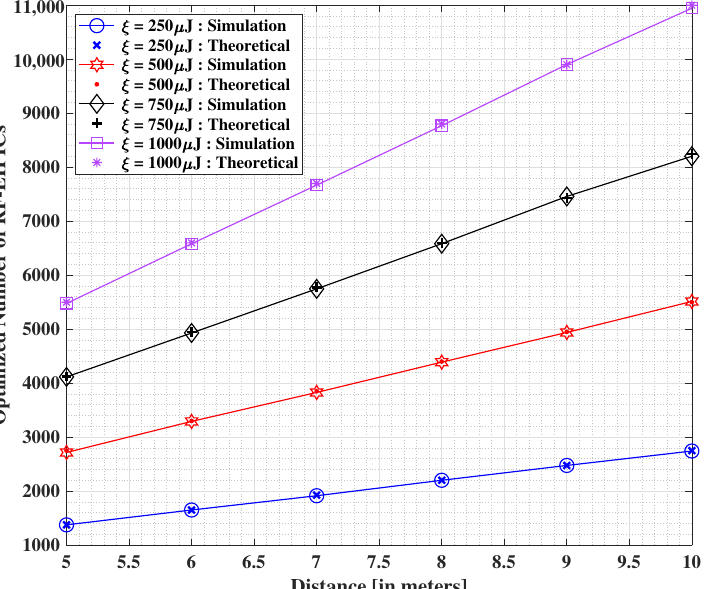
Figure 11. Optimized number of RF-EH ICs versus varying separation distances between the transmitter and end user, for different values of demanded harvested energy, where P Max = 10